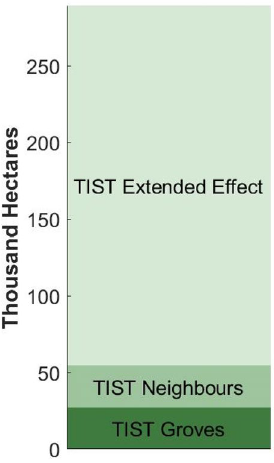
Figure 5. Total extent of greening associated with TIST